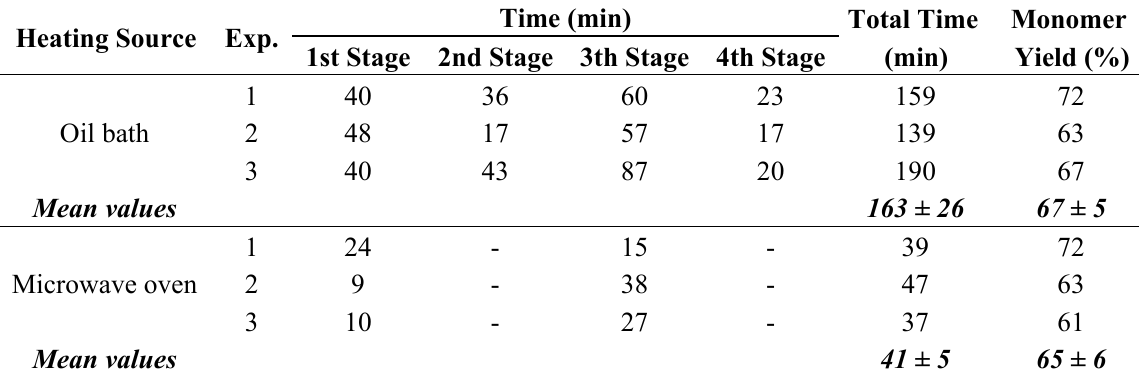
Table 1. Results of BCA direct synthesis by an oil bath and by a microwave oven. Exp. = Experiments.